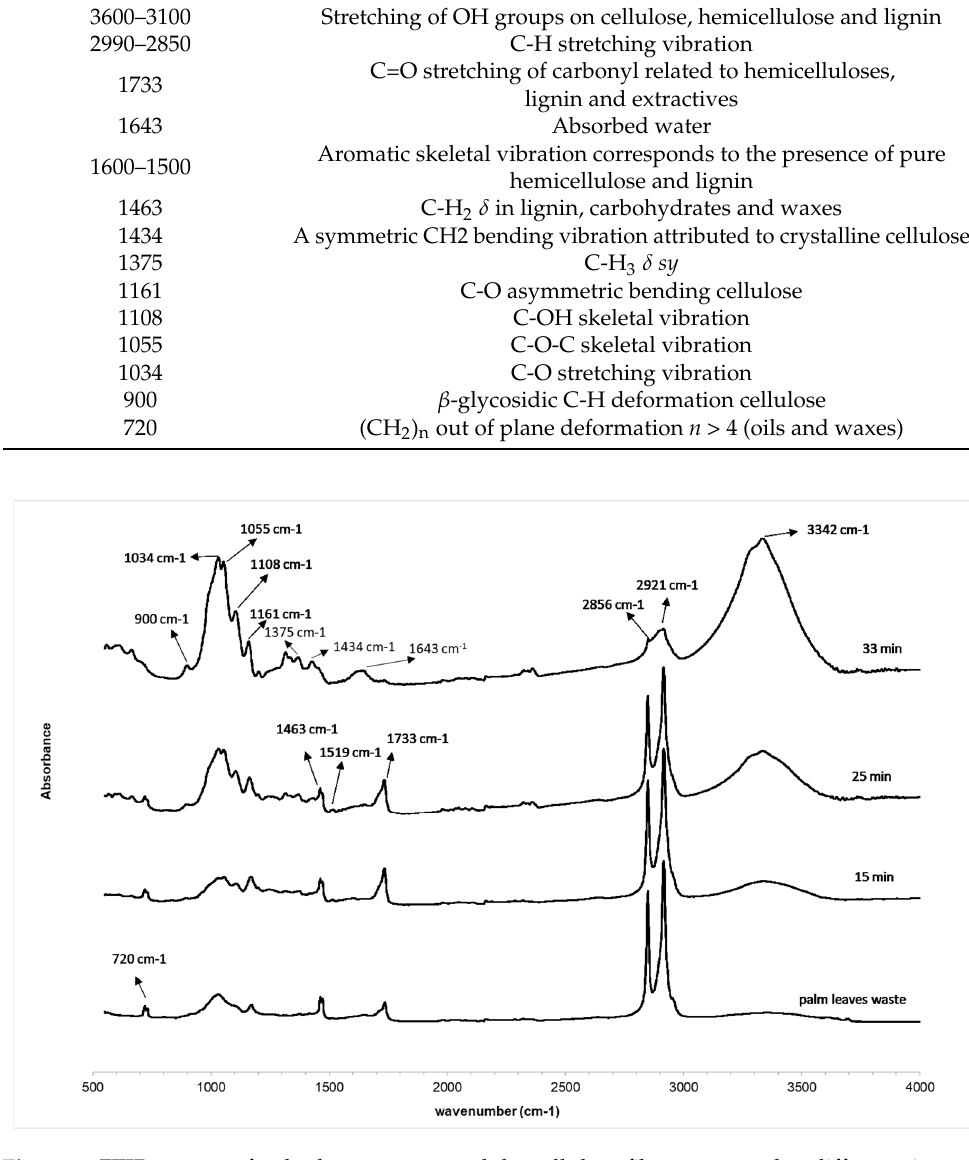
Figure 3. FTIR spectra of palm leaves waste and the cellulose fibers extracted at different times of steam-explosion treatment.